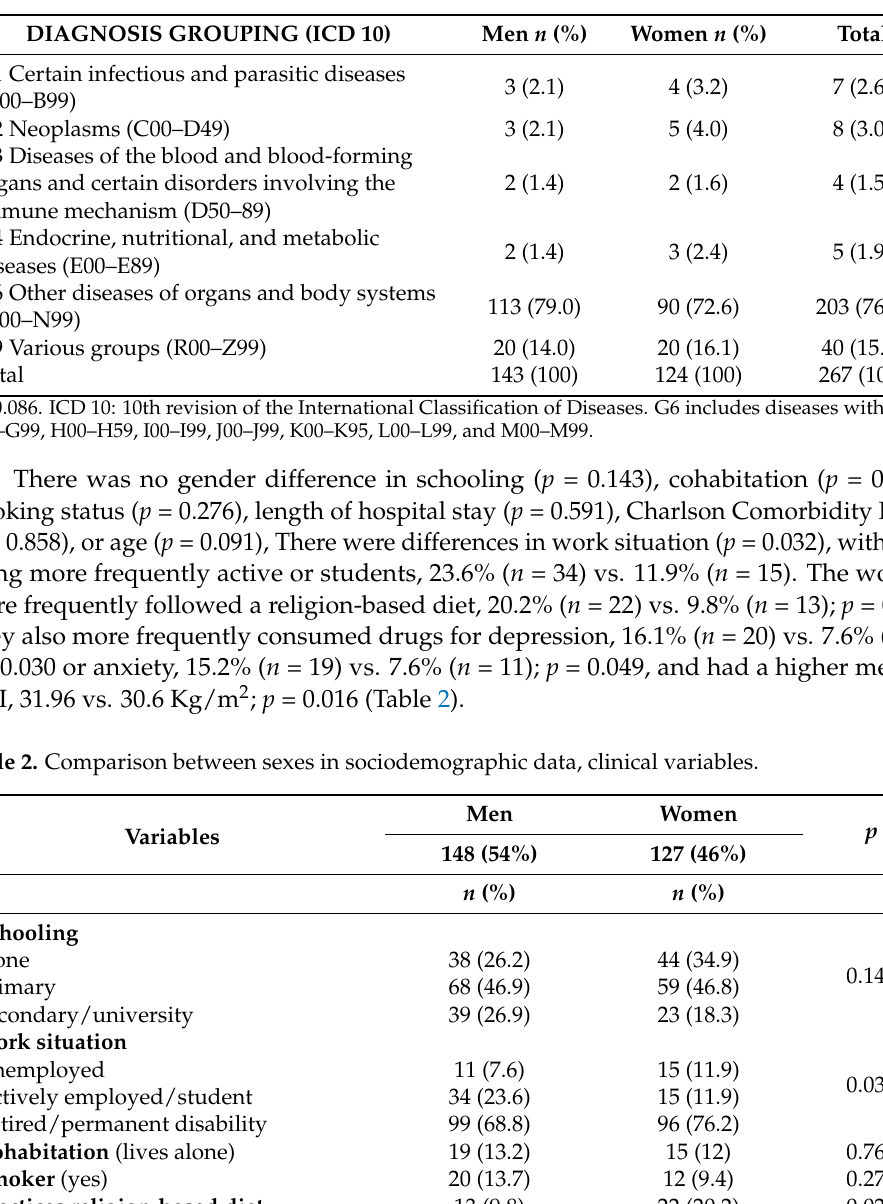
Table 1. Distribution of diagnoses at patient admission.